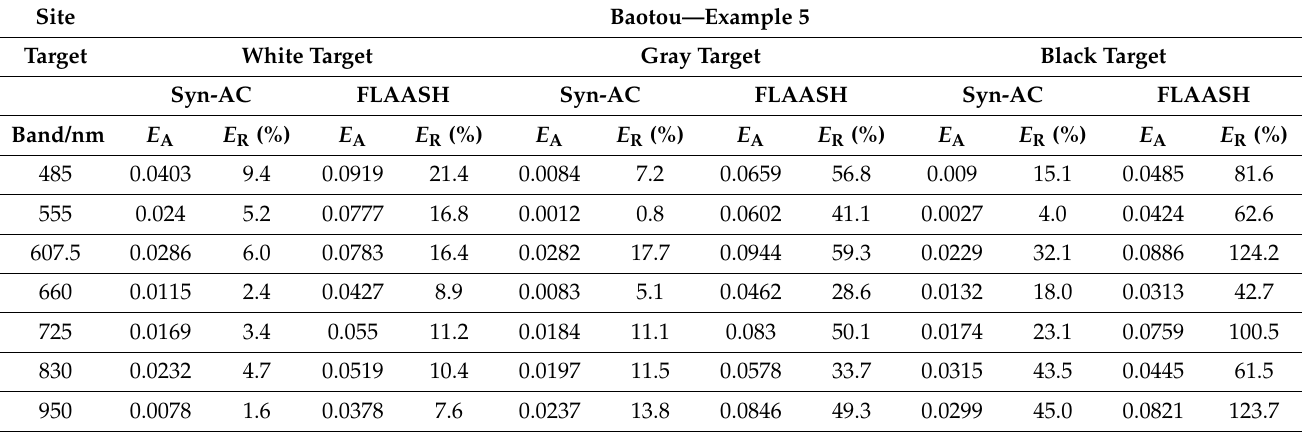
Table 12. Performance comparison between Syn-AC and FLAASH, based on Example 5.